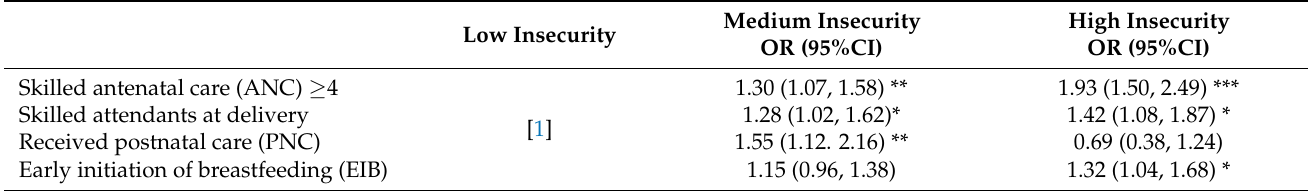
Table 4. Associations between self-reported insecurity with maternal health-seeking behaviours †.